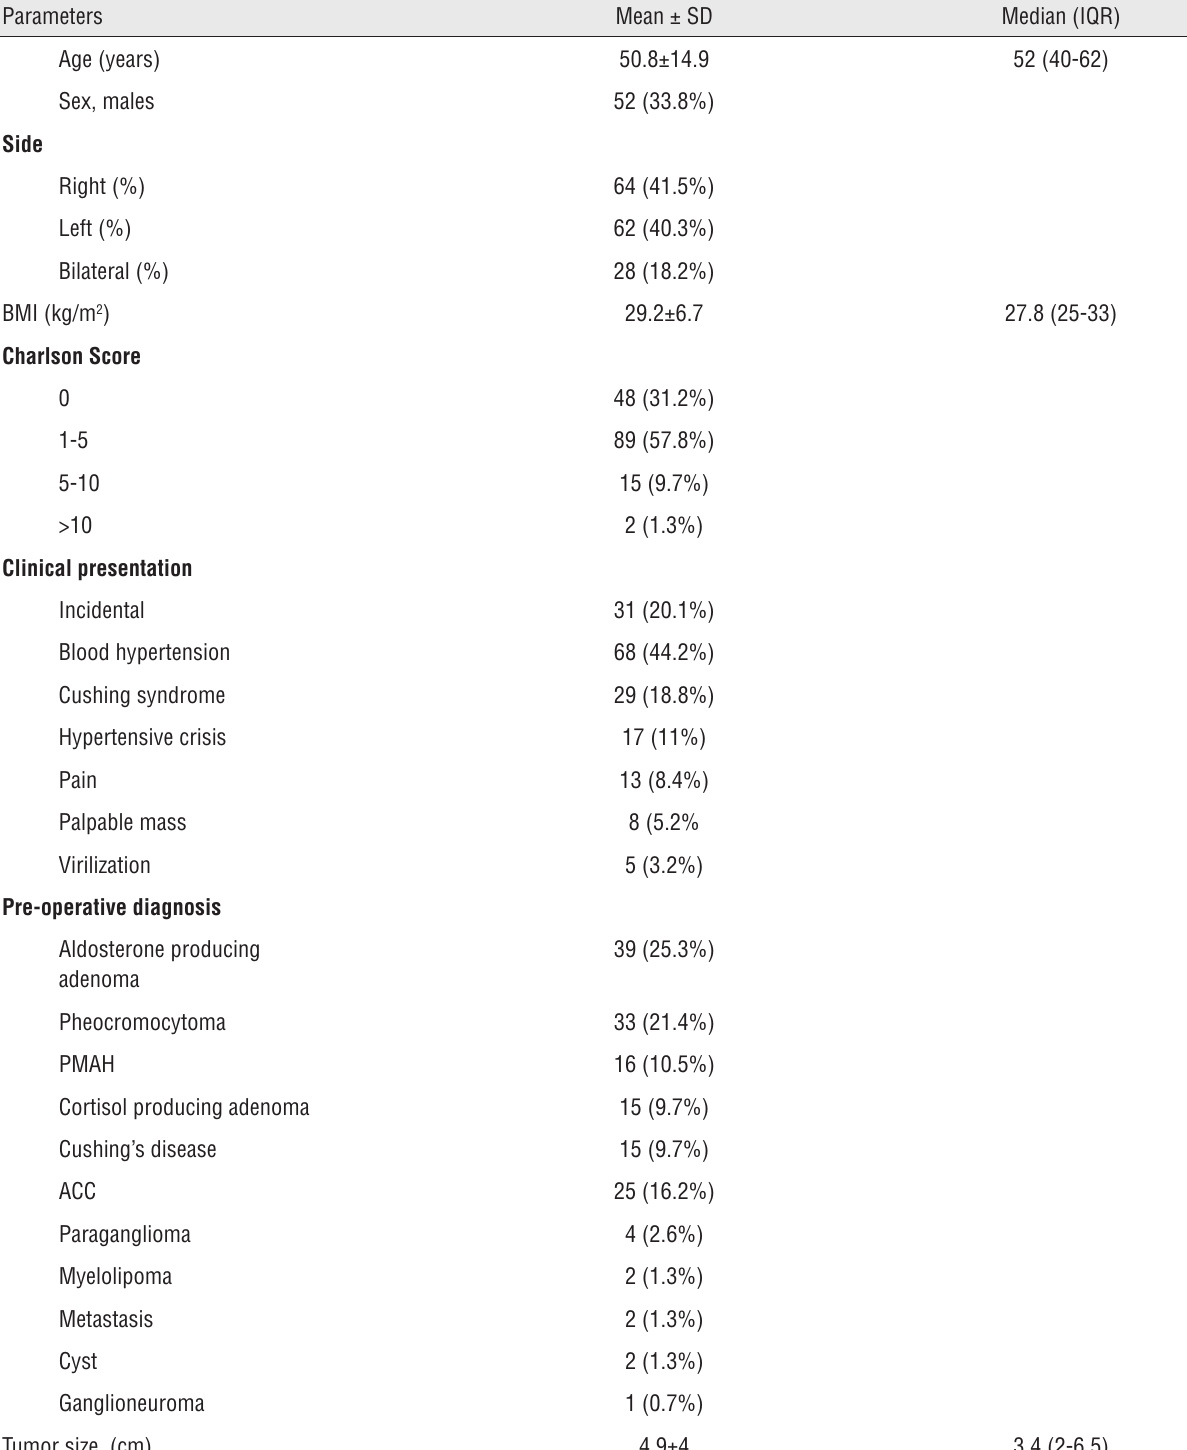
Table 3 – Demographic and clinical presentation